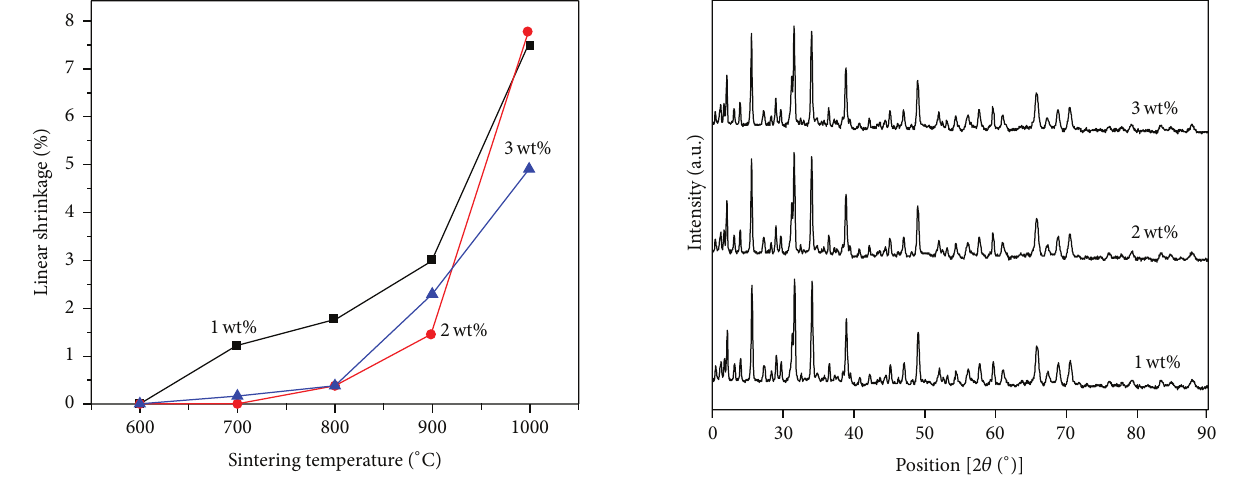
Figure 4: XRD patterns of various percentages of Eu 2 O 3 doped willemite samples sintered at 1000 ∘ C for 4 h.